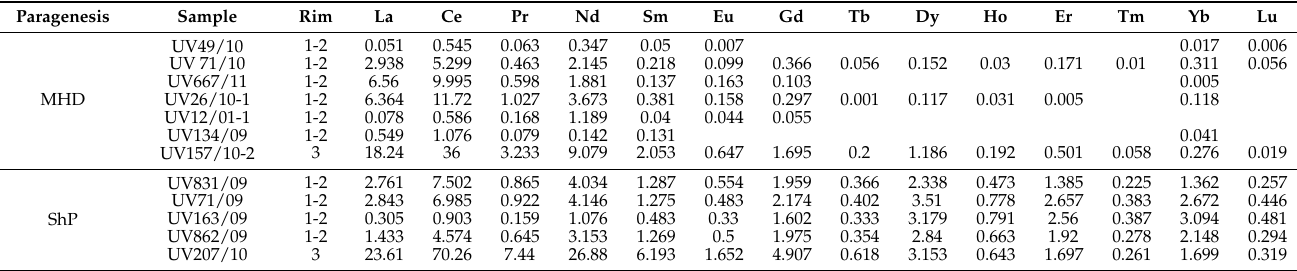
Table A3. Rare-earth composition (in ppm) of MHD and ShP garnet rims.